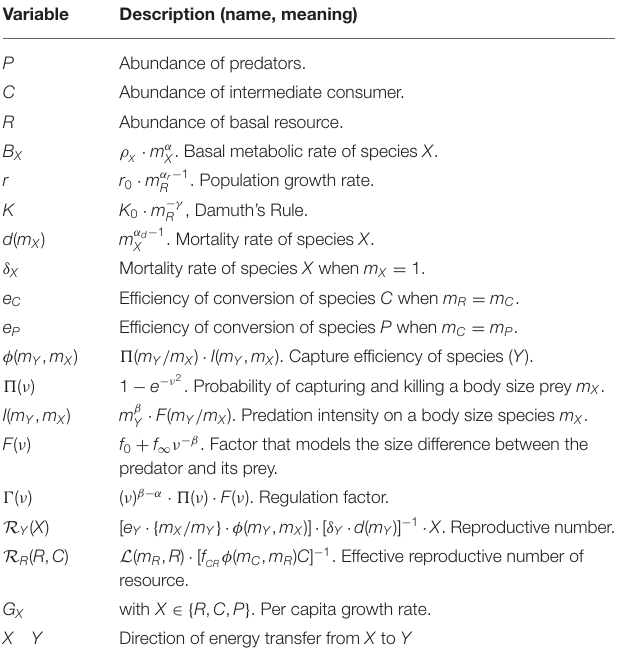
TABLE 1 | Definition and description of variables and parameters included into the model.